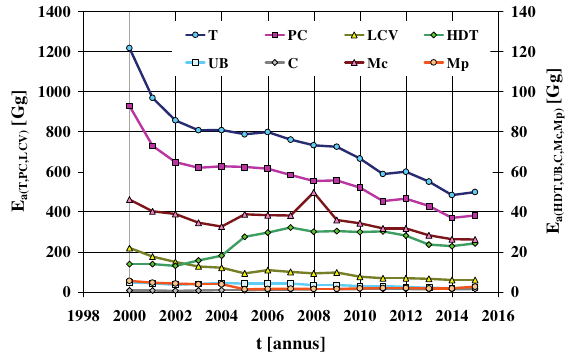
Fig. 6. Average vehicle velocity per cumulated vehicle category, under model traffic conditions: urban